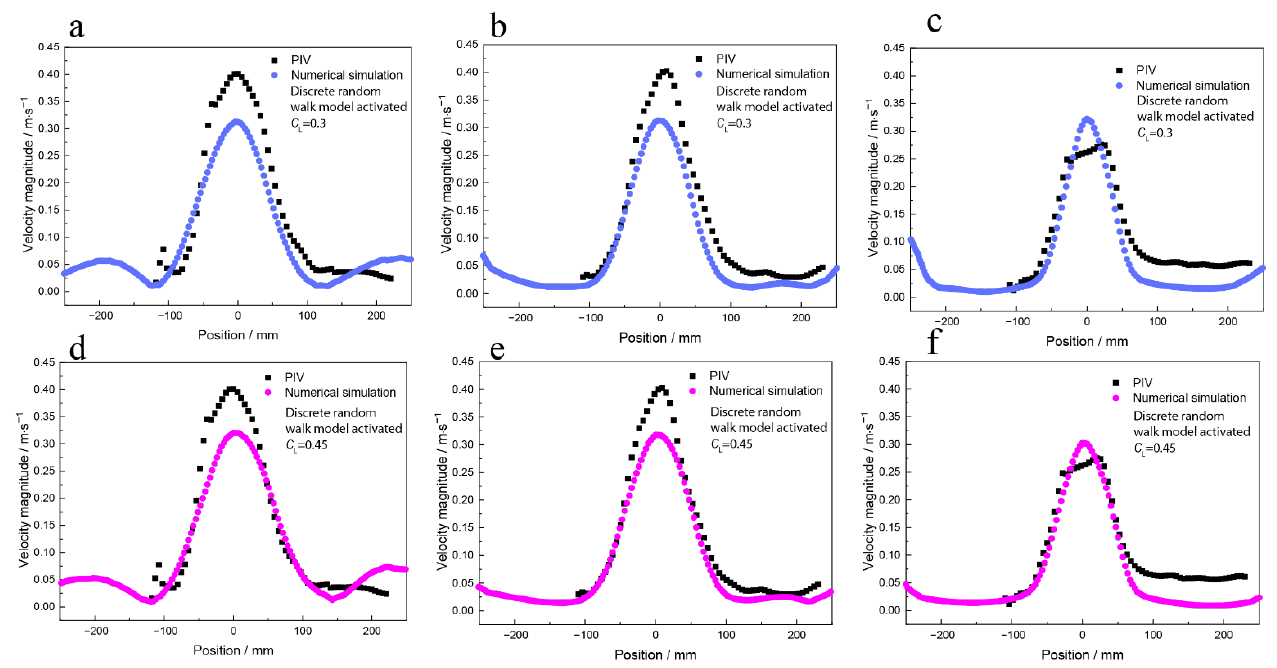
Figure 6. The quantitative velocity magnitude data of numerical simulation of water model and PIV measurements results, when the random walk model was activated and C L was 0.3 ( a ) near the water surface, ( b ) under the water surface by 100 mm, and ( c ) under the water surface by 200 mm; when the random walk model was activated and the C L was 0.45 ( d ) near the water surface, ( e ) under the water surface by 100 mm, and ( f ) under the water surface by 200 mm.